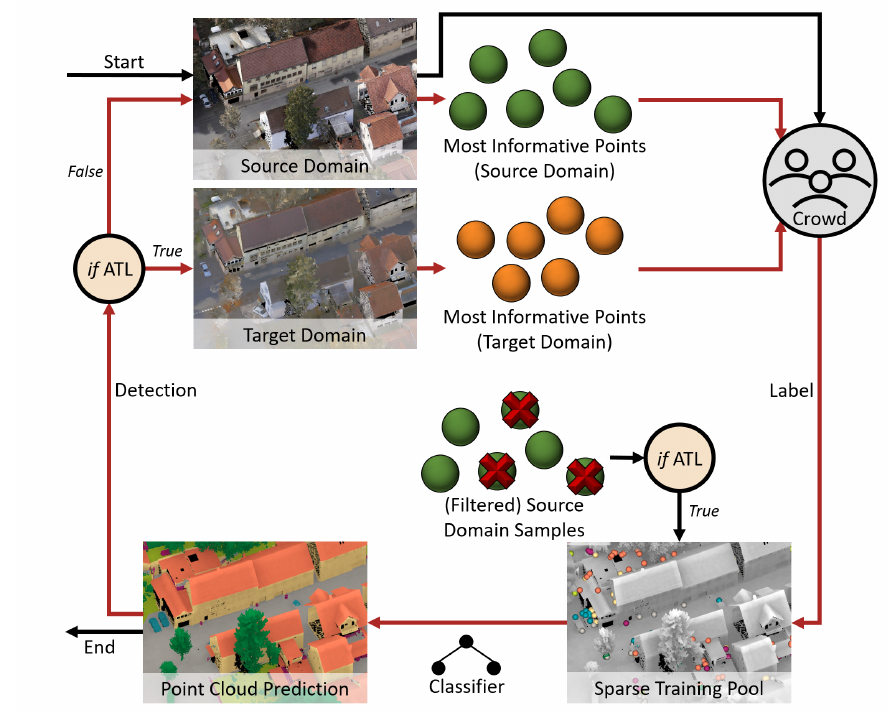
Figure 1. Crowd-powered pipeline for DA to adapt a classifier learned on a source domain to a related target domain. The A(T)L loop is indicated by red